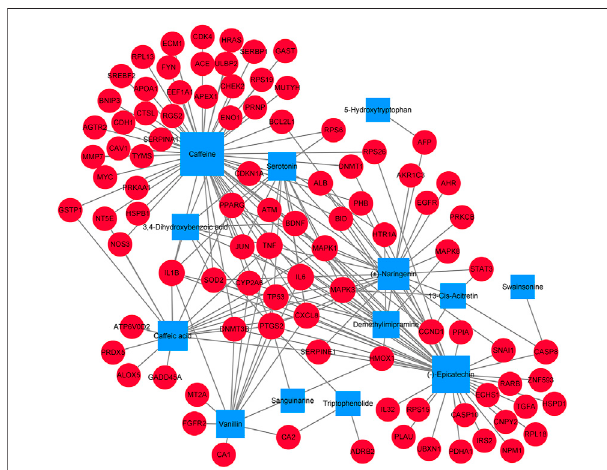
FIGURE 3 | Component-target network of D. of fi cinale extract and gastric cancer. The blue nodes represent candidate active components, and the red nodes represent potential protein targets. The edges represent the interactions between them, and the node sizes are proportional to the node degrees.